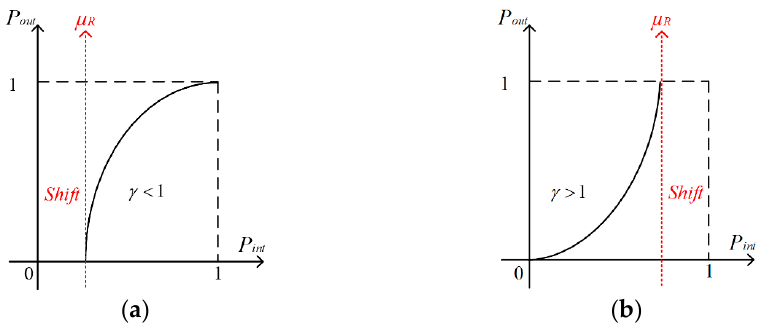
Figure 8. Shift GCF operation, ( a ) Shift GCF operation response to γ < 1, ( b ) Shift GCF operation response to γ > 1.